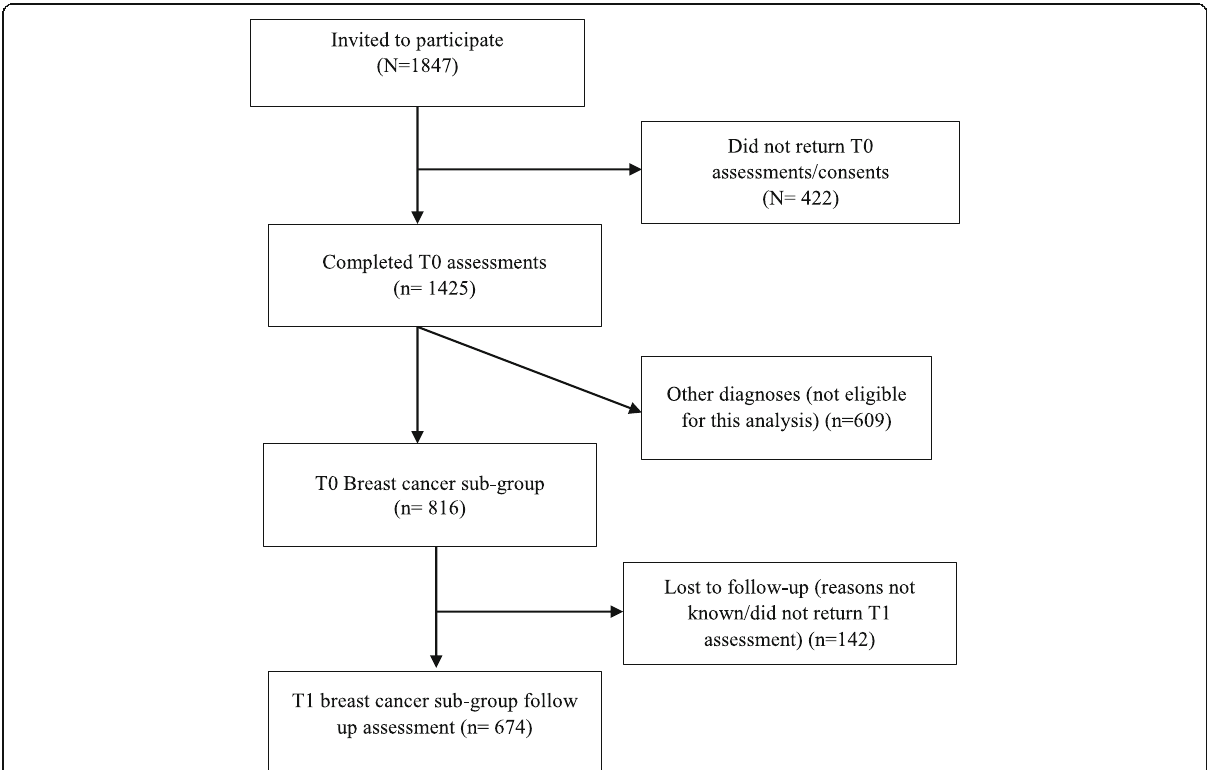
Fig. 1 Flow chart of participants ’ study inclusion. T0, baseline (at the end of treatment); T1, 6 months after baseline